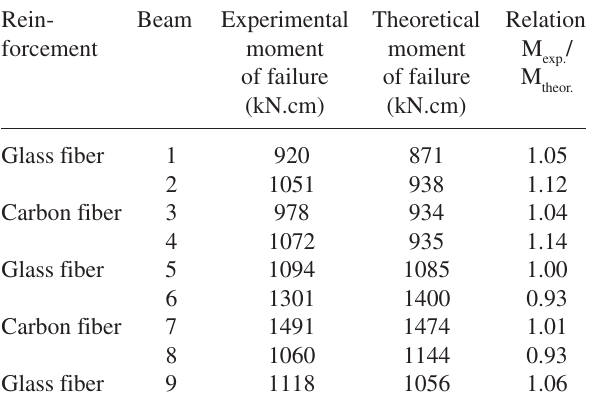
valid for the evaluation of fiber-reinforced timber